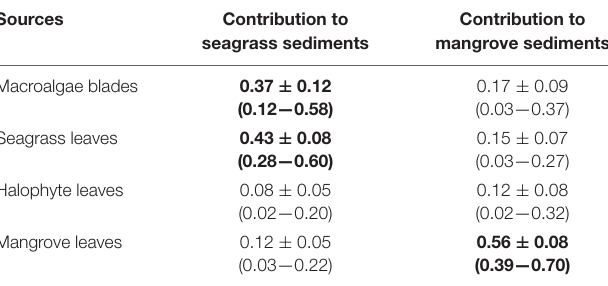
TABLE 3 | Contribution of each source to the accumulated organic matter in seagrass and mangrove sediments estimated using stable isotope mixing models ( simmr ), showing mean ± SD and 95% credible intervals in